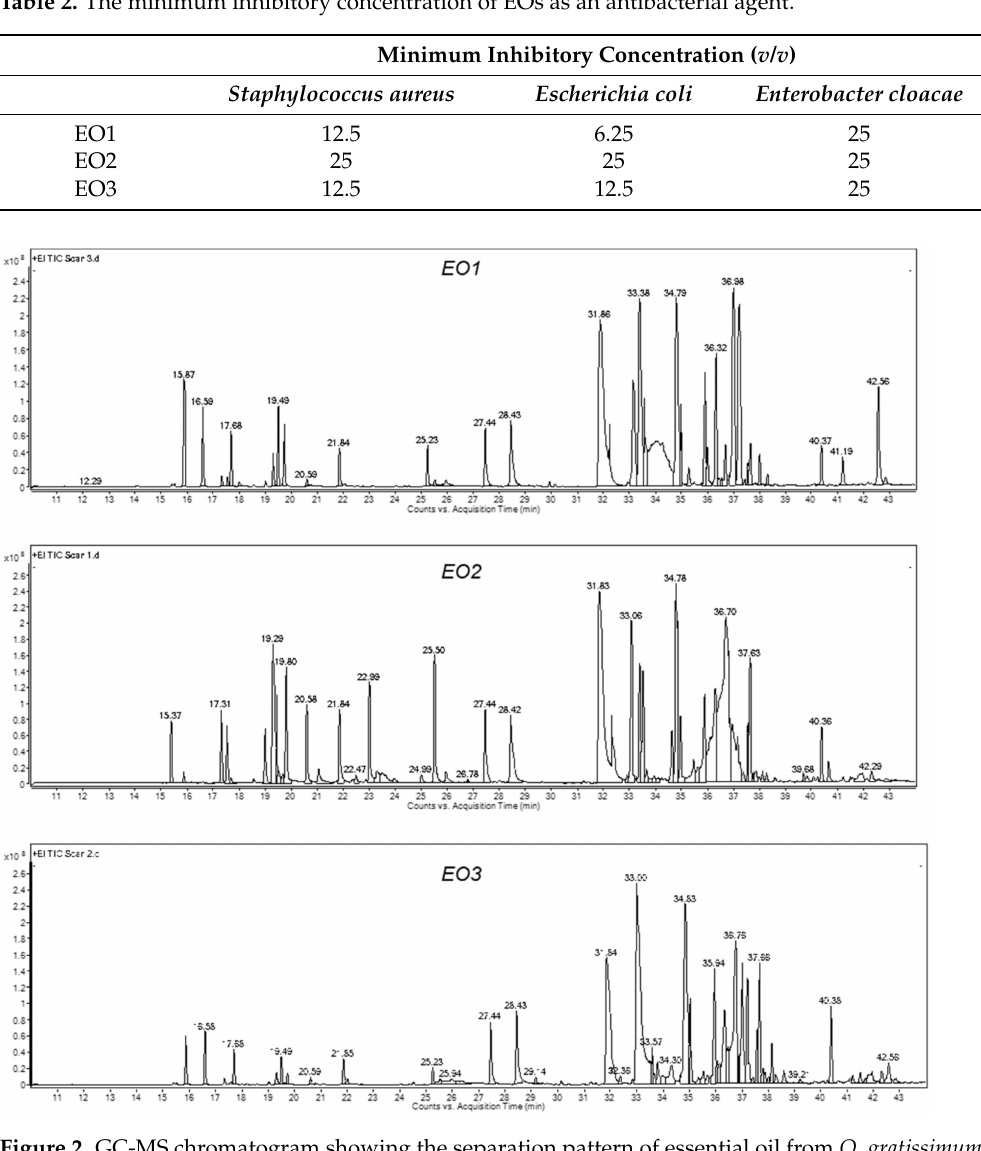
Figure 2. GC-MS chromatogram showing the separation pattern of essential oil from O. gratissimum (EO1), O. tenuiflorum (EO2), and O. sanctum